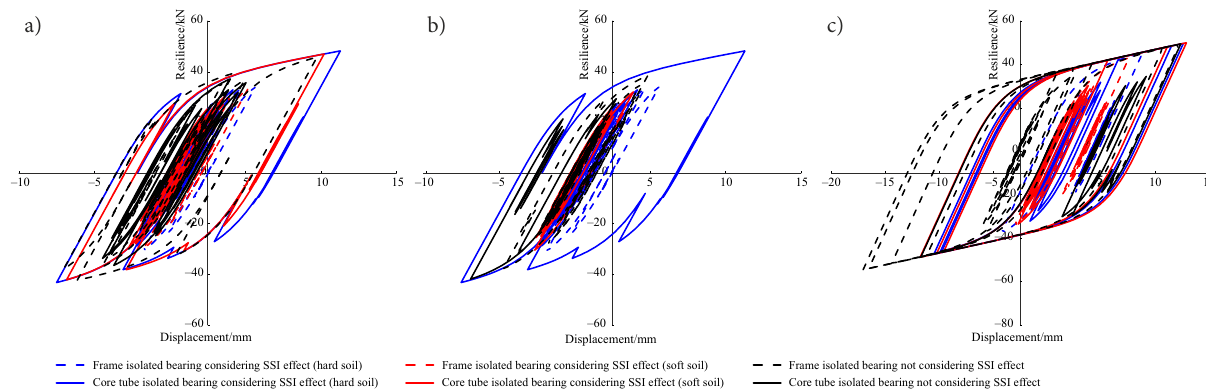
Frame isolated bearing not considering SSI effect Frame isolated bearing considering SSI effect (soft soil) Frame isolated bearing considering SSI effect (hard soil) Core tube isolated bearing not considering SSI effect Core tube isolated bearing considering SSI effect (soft soil) Core tube isolated bearing considering SSI effect (hard soil) Figure 16. Hysteretic curve of isolated bearings: a – hysteresis curve of seismic isolated bearing under Nanjing wave; b – hysteresis curve of seismic isolated bearing under Lanzhou wave; c – hysteresis curve of seismic isolated bearing under Tianjin